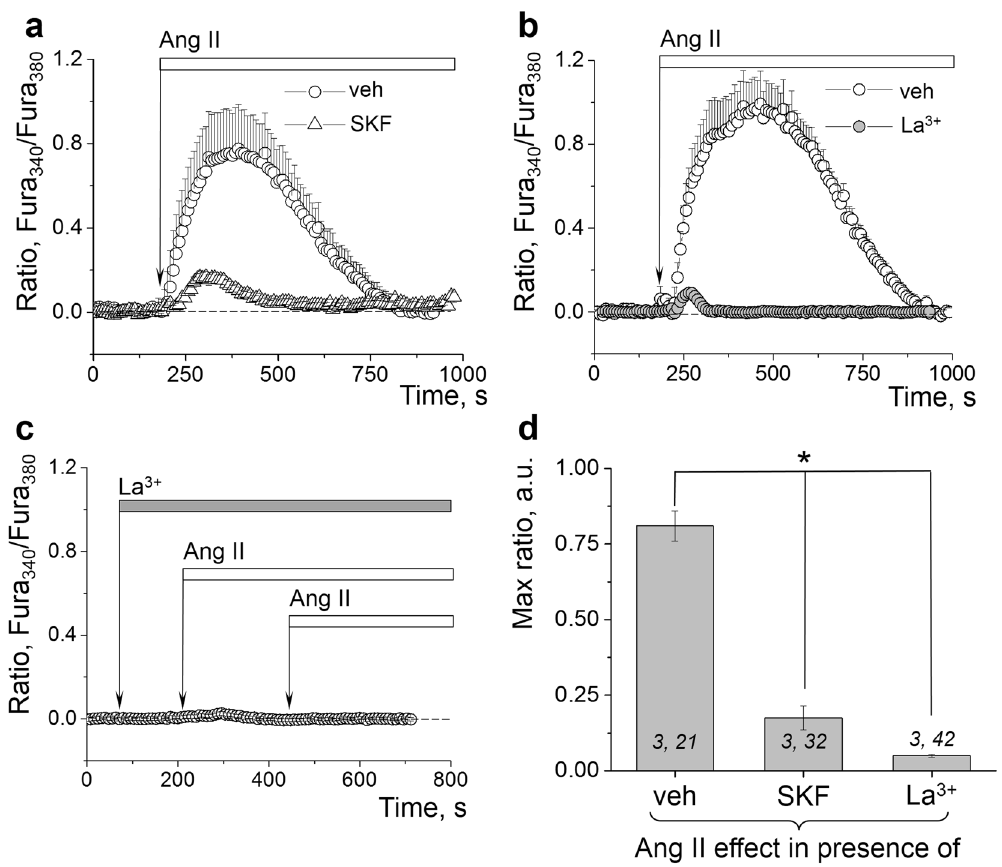
Figure 6. Ang II–dependent calcium influx in the podocytes mediated via TRPC channels. ( a ) Representative effects of the TRPC channel blocker SKF 96365 (SKF, 1 µ M, 5 min) on Ca 2 + transients evoked in the podocytes by 10 µ M Ang II. ( b ) Representative transient demonstrating that 50 µ M LaCl 3 (upon 10 min pre-incubation) precludes the increase in calcium influx in response to Ang II in the podocytes. ( c ) Transient illustrating the lack of a potentiating effect of LaCl 3 on calcium influx, and immediate inhibitory effect on Ang II-evoked calcium transients (10 µ M Ang II was applied twice consecutively). ( d ) Graph summarizing the effects of Ang II on calcium influx in the podocytes in presence of SKF or LaCl 3 . ( i , j ) noted on graph is number of animals ( i ) and podocytes ( j ) analyzed in each group. * P < 0.01 versus Ang